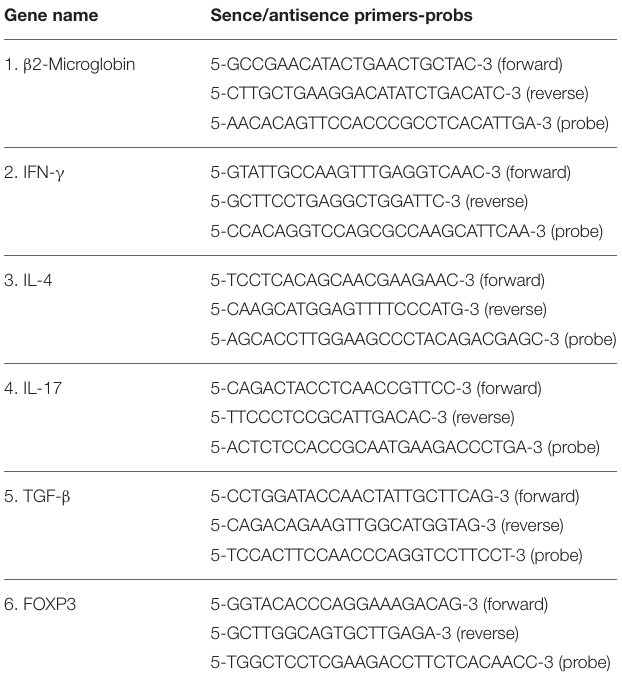
TABLE 1 | Sequences of primers used for real-time